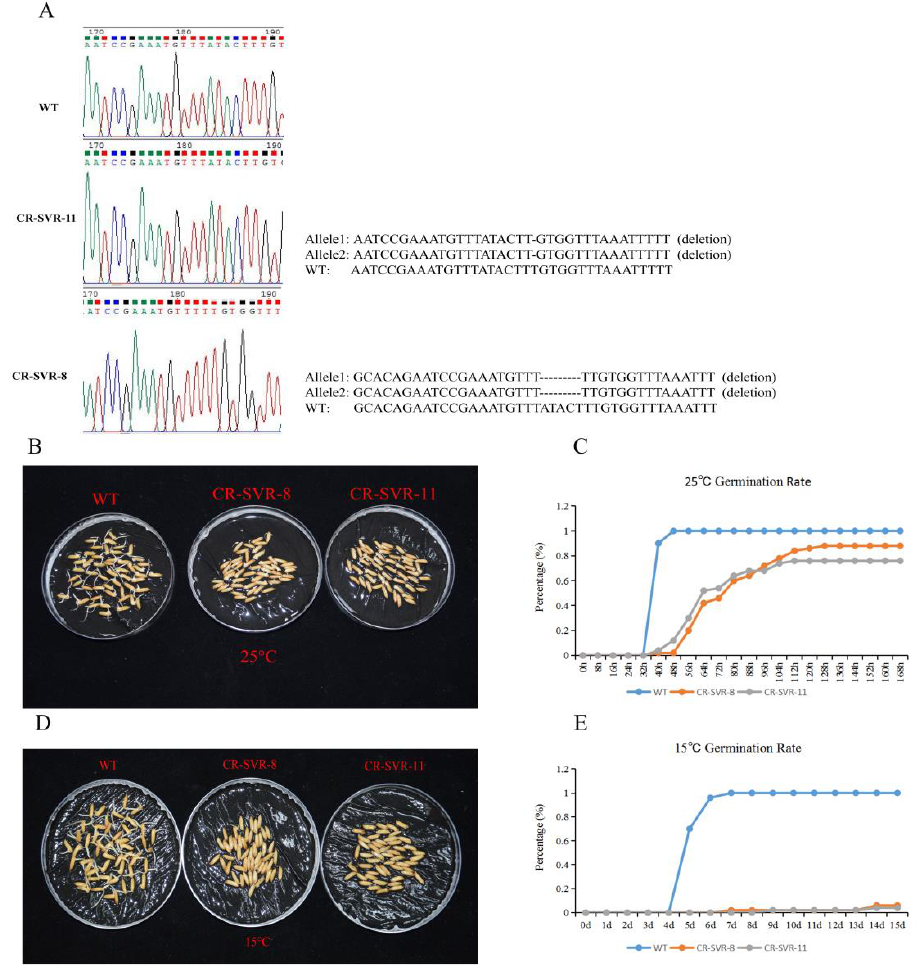
Figure 10. CRISPR/Cas9-engineered mutations in SVR cause delay of germination in the T 1 genera- tion. ( A ) Genotype of CR-SVR-8 and CR-SVR-11 in the T 1 generation. ( B ) Germination status of two independent homozygous mutants CR-SVR-8 and CR-SVR-11 were compared with WT in 64 h im- bibition at 25 °C. ( C ) Germination rate of CR-SVR-8 and CR-SVR-11 at 25 °C. ( D ) Germination status of two independent homozygous mutants CR-SVR-8 and CR-SVR-11 were compared with WT in 15d imbibition at 15 °C. ( E ) Germination rate of CR-SVR-8 and CR-SVR-11 at 15 °C.